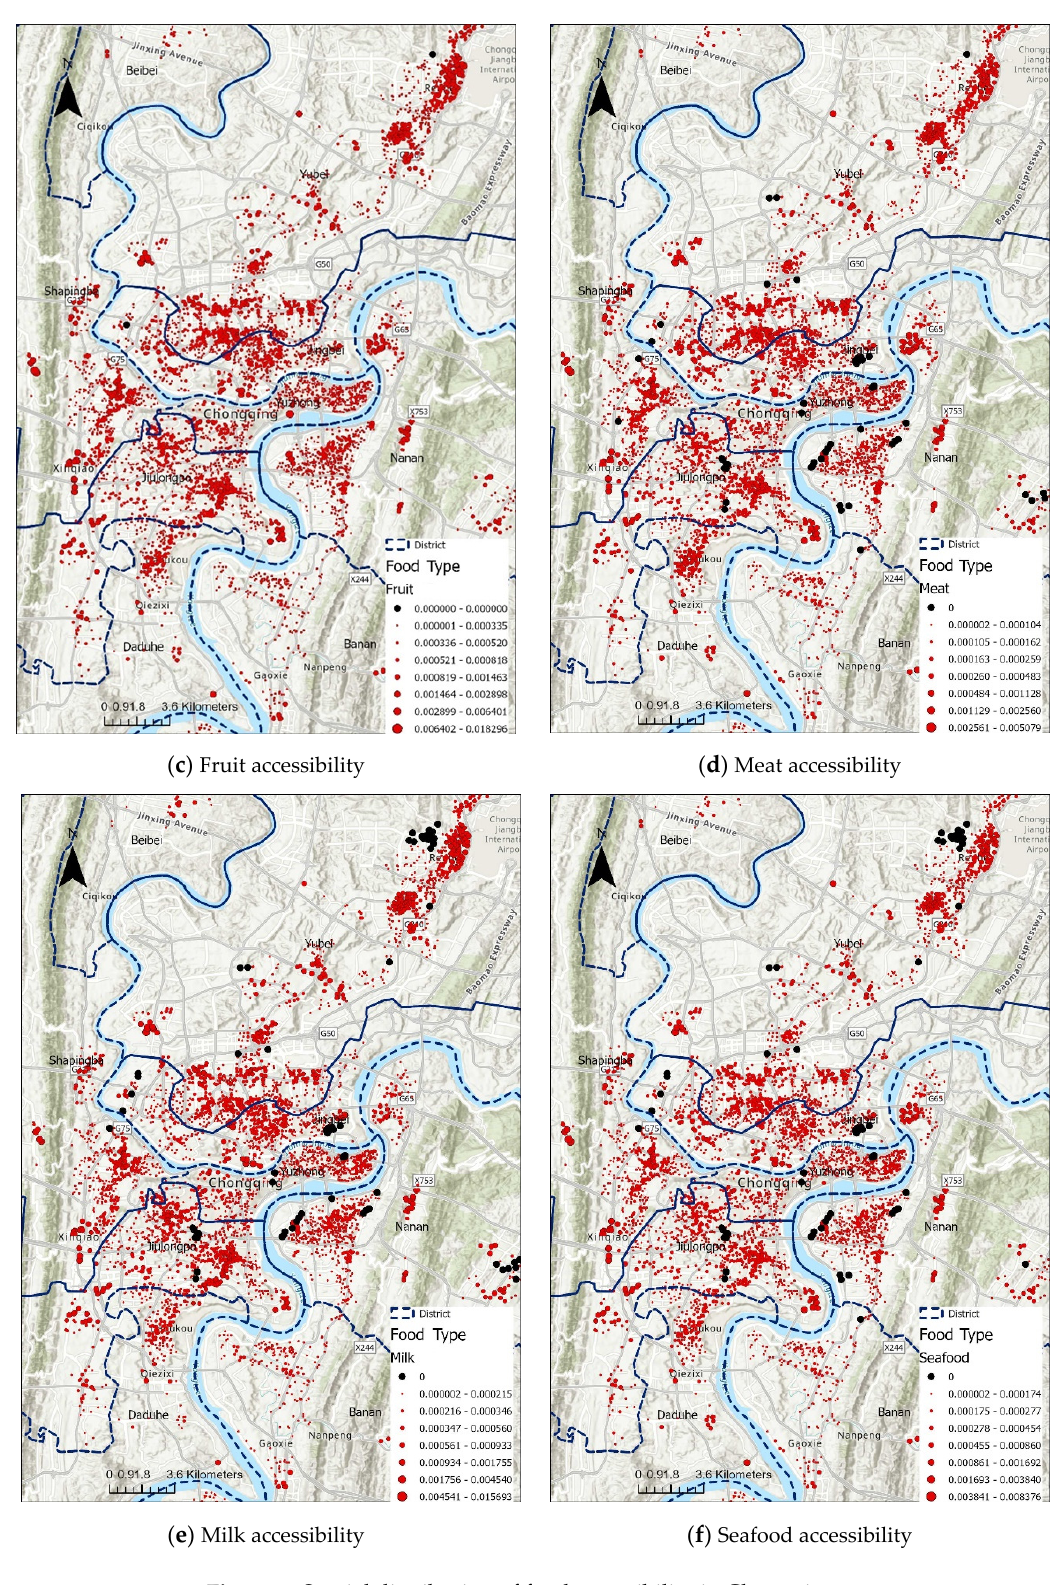
Figure 9. Spatial distribution of food accessibility in Chongqing. The AI values of various food categories were categorized and plotted as box-and- whisker plots (Figure 10). When combining all types of accessibility indicators, the accessi- bility of grain and oil exceeded those of several other food categories, reflecting the